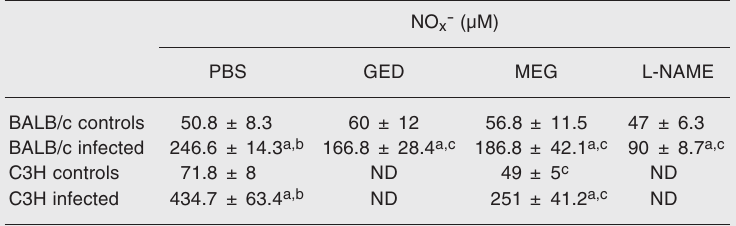
Table 1. NO x- levels in plasma of Trypanosoma cruzi -infected and treated mice and controls.